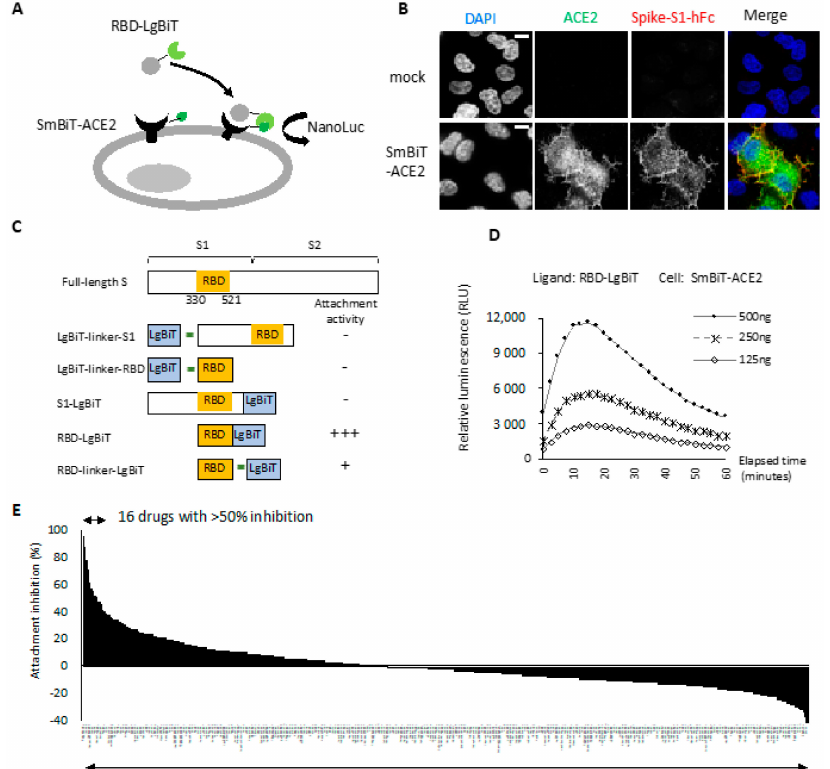
Figure 1. Identification of viral entry inhibitors by the cell-based RBD-ACE2 attachment assay. ( A ) Schematic of the RBD-ACE2 attachment assay. Reconstitution of NanoLuc occurs when recombi- nant RBD-LgBiT ligand attaches to the SmBiT-ACE2 on the cell surface of HeLa cells. RBD attachment activity is monitored by detecting bioluminescence signal following ligand treatment. ( B ) HeLa